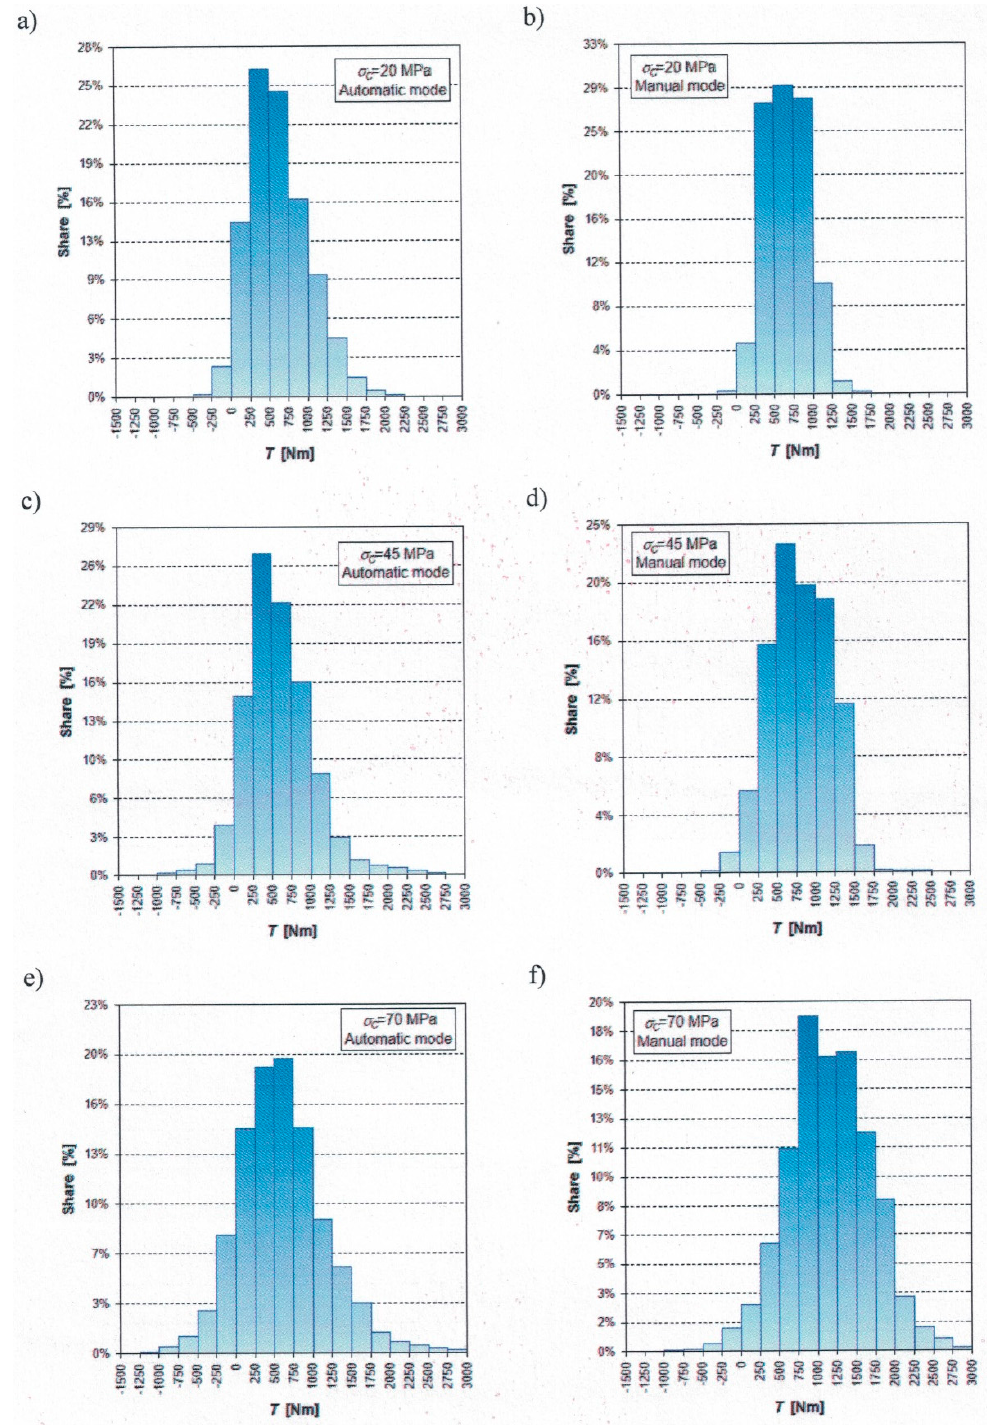
Figure 8. Histograms of the torque value distribution on the motor shaft in the cutting heads drive during simulated rock mining with three different uniaxial compressive strengths in ( a , c , e ) auto- matic control mode and ( b , d , f ) manual control